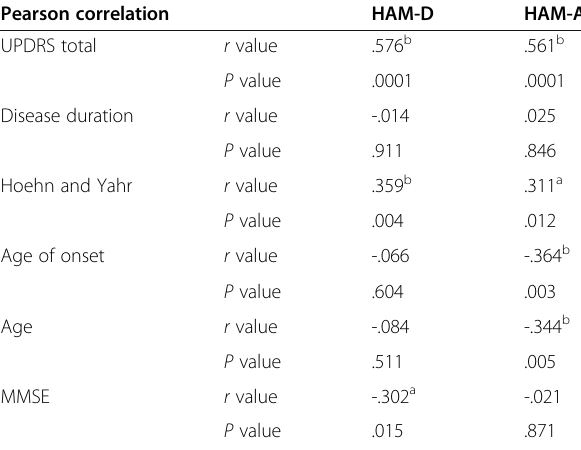
Table 4 Correlation between anxiety and depression and various parametric variables Pearson correlation